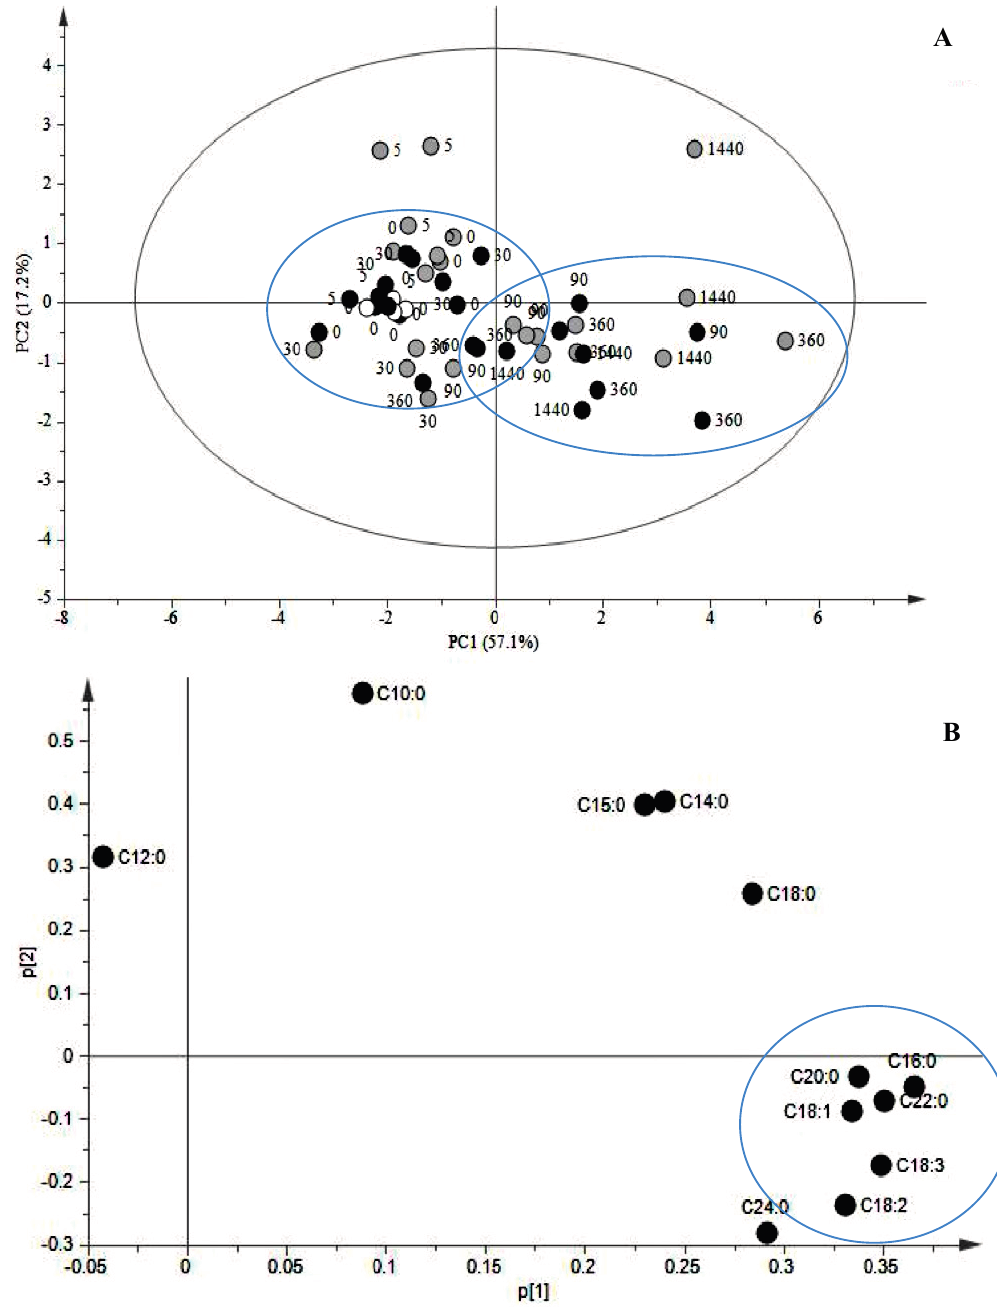
Figure 1. Multivariate data analysis of cell suspensions of C. roseus treated with JA. ( A ) PCA scores plot generated from PCA using GC-MS normalized data (PC1 vs. PC2) of treated cells and controls. The variances accounted by PC1 and PC2 were 57.1% and 17.2%, respectively. ( B ) PCA loading plot from PCA (PC1 vs. PC2) showing the most influential FA. Black circles: JA-treated cells; white circles: untreated cells; grey circles: mock (40% EtOH).